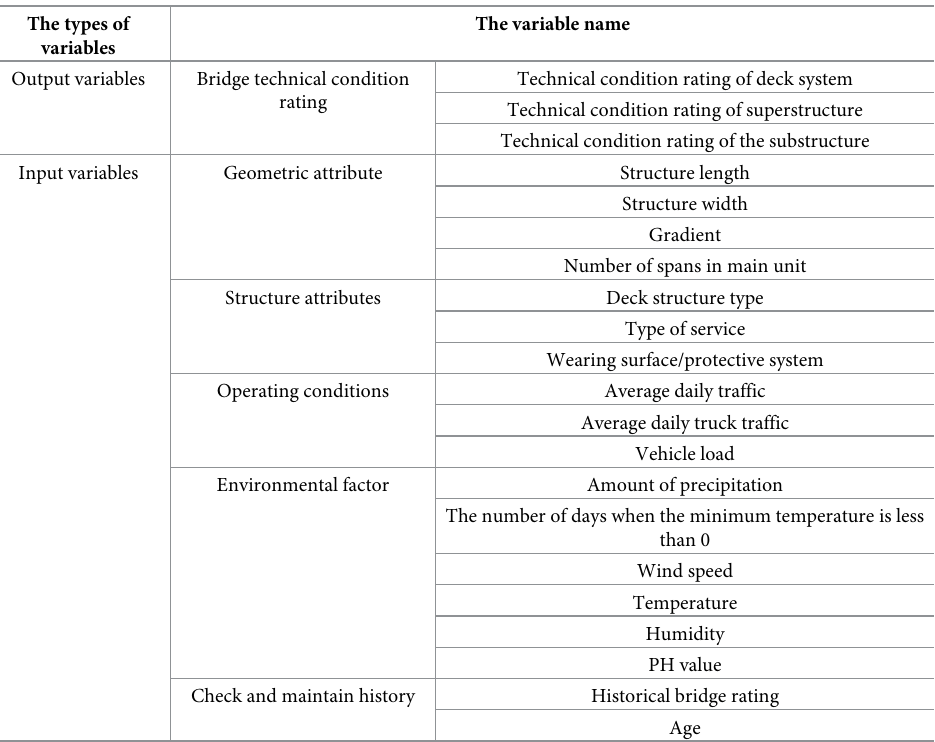
Table 1. Variable selection of deterioration prediction model for concrete beam